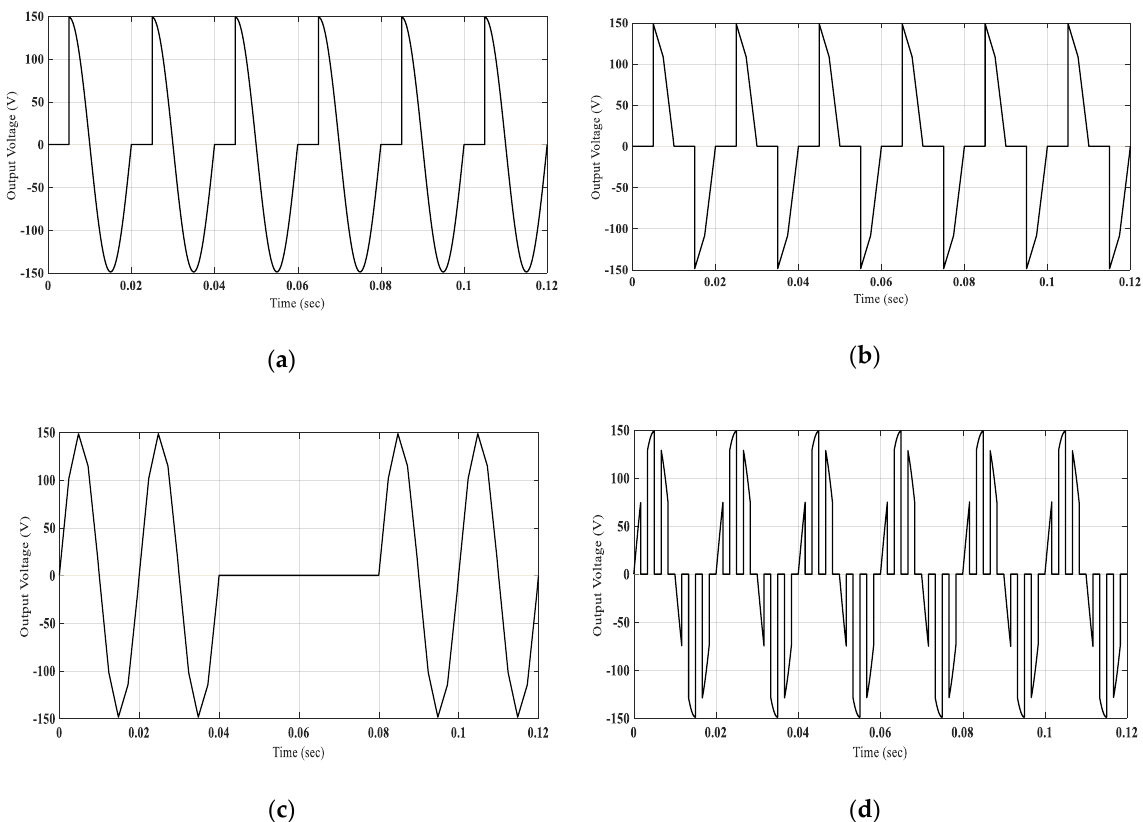
Figure 8. Simulation waveforms of the output voltage: ( a ) phase-angle unipolar control; ( b ) phase-angle bipolar control; ( c ) on-off cycle control; ( d ) PWM control. Table 2. Harmonic coefficients of output unipolar voltage control with a phase-angle of π /2. Harmonic Order ( n